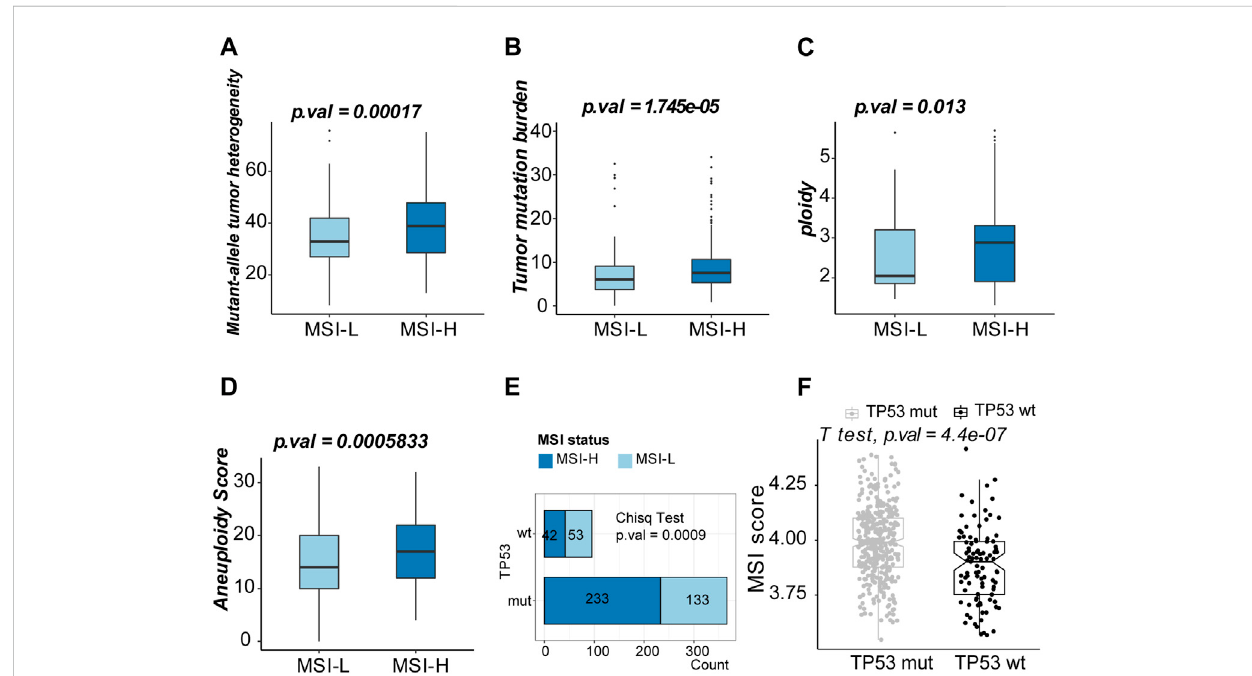
FIGURE 3 Exploration of the genomic features of MSI-H and MSI-L groups. (A) Boxplot of mutant – allele heterogeneity (MATH) (indicating intratumor heterogeneity). (B) Boxplot oftumor mutation burden (TMB). (C) Boxplot ofploidy(DNA content). (D) Boxplotoftheaneuploidyscore. (E) Comparisonof the MSI scores between TP53 mut and TP53 wt groups. (F) Top 10 mutated genes in the MSI-L group. (G) Top ten mutated genes in the MSI-H group.